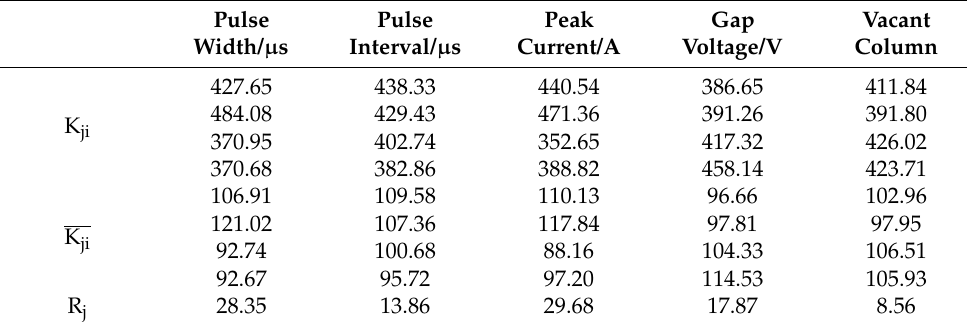
Table 3. Four factors and four levels of orthogonal test analysis table.